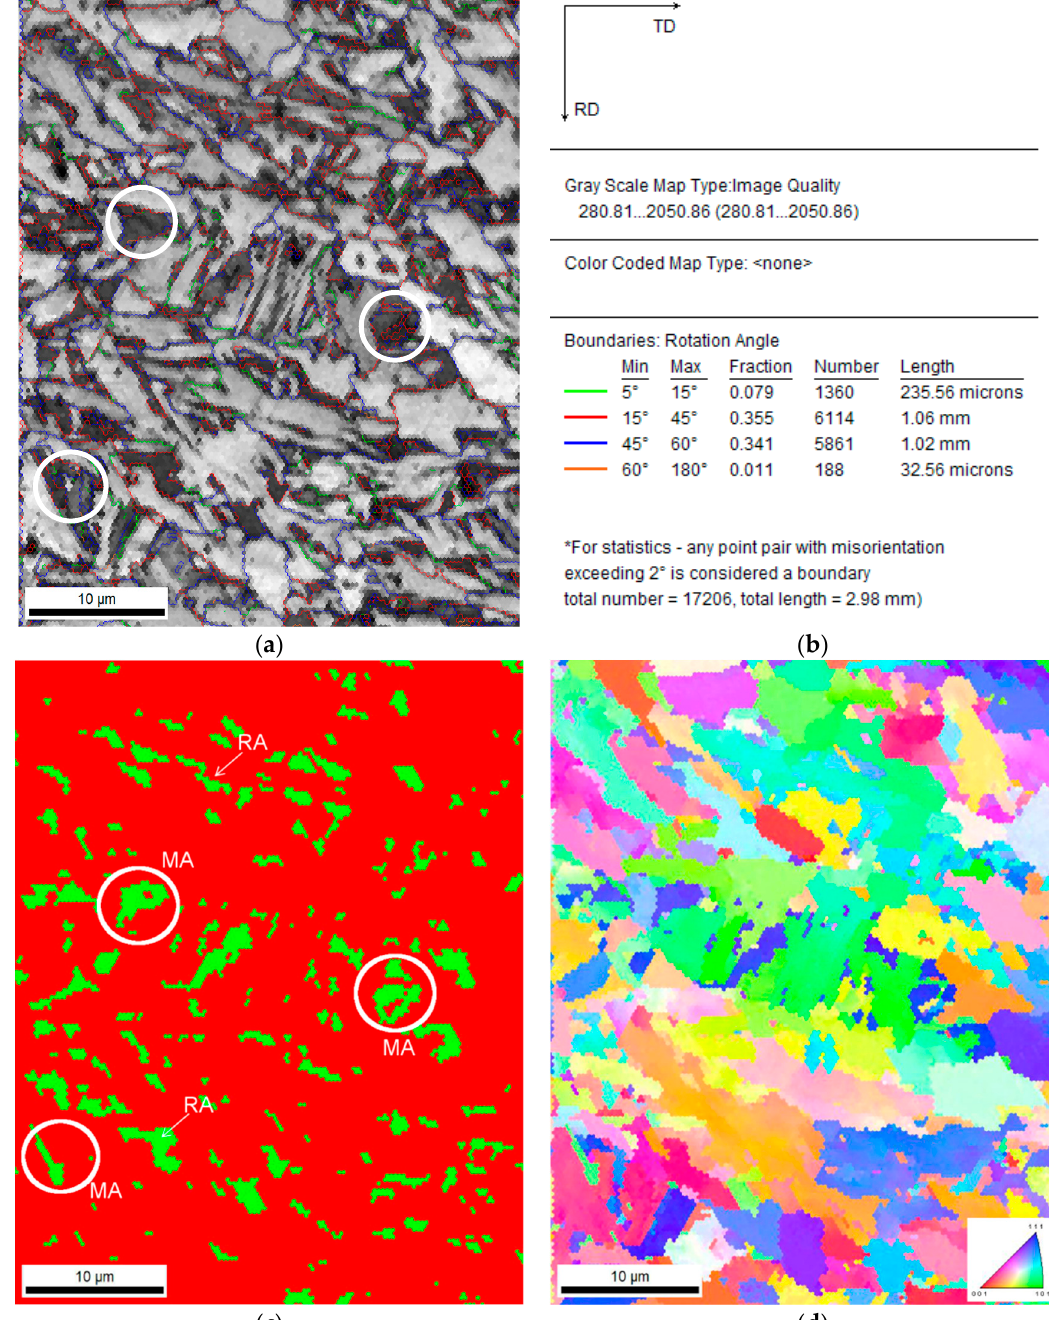
Figure 4. Image of the steel in the initial state (non-deformed). Image quality (IQ) map ( a ), statistical analysis of grain boundaries for the IQ map ( b ), phase distribution map—retained austenite (RA) as green ( c ), orientation map ( d ); MA (martensite–austenite) constituents.